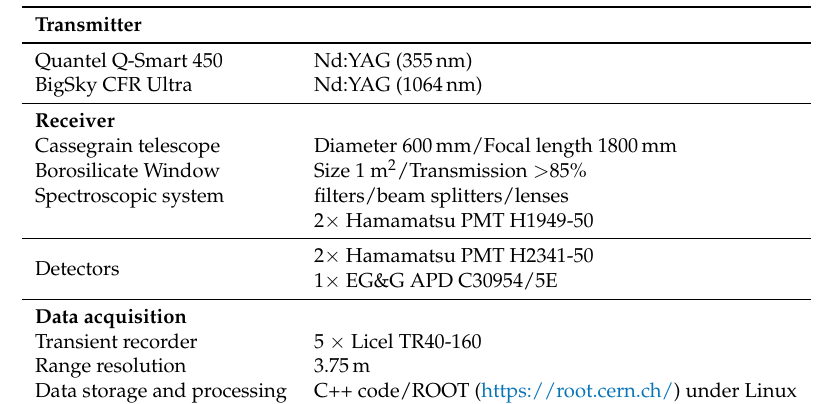
Table 1. Main components of the custom-made polarization Raman-Mie LiDAR in Ajdovšˇcina, which was the main device for the investigation of aerosol properties above the Vipava